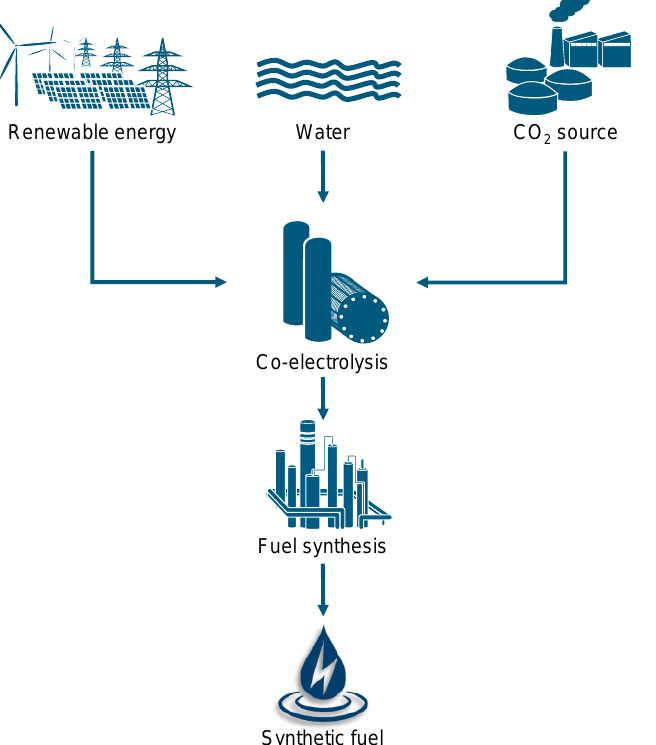
Figure 1. Schematic of a power-to-fuel process with co-electrolysis.